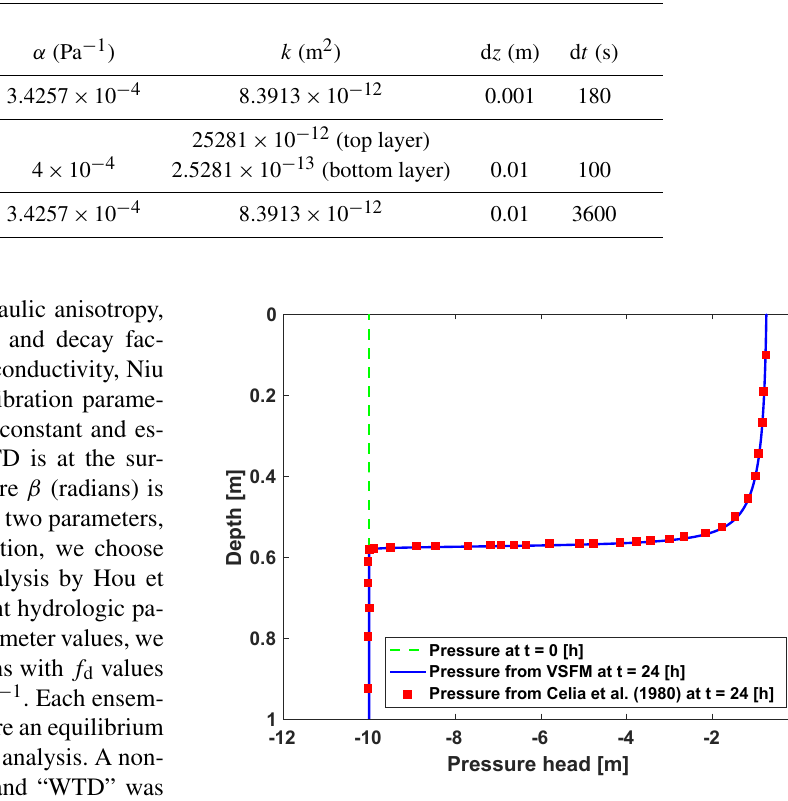
Figure 1. Comparison of VSFM simulated pressure profile (blue line) against data (red square) reported in Celia et al. (1990) at time = 24h for infiltration in a dry soil column; Initial pressure con- dition is shown by green